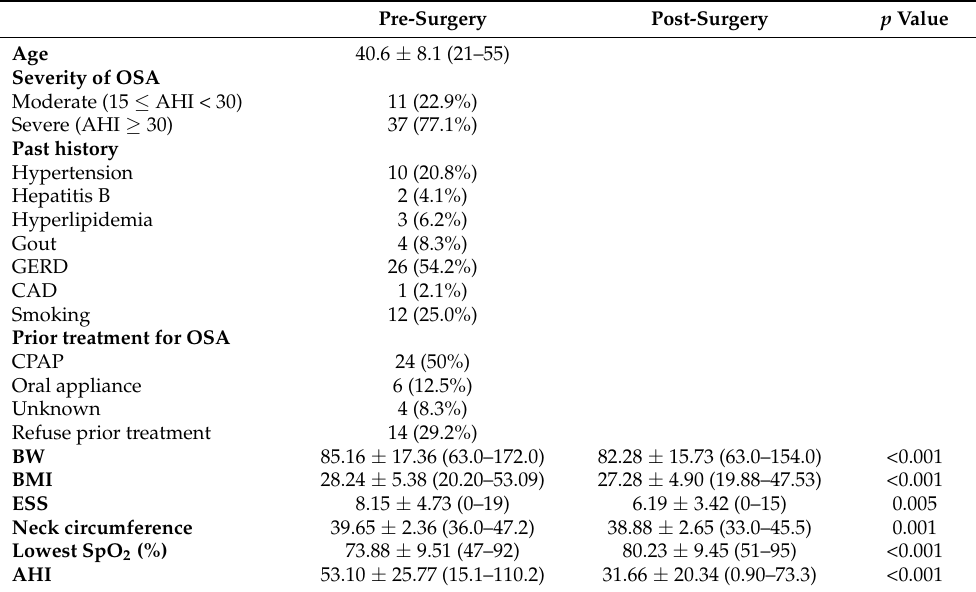
Table 1. Baseline and postoperative characteristics (total N =